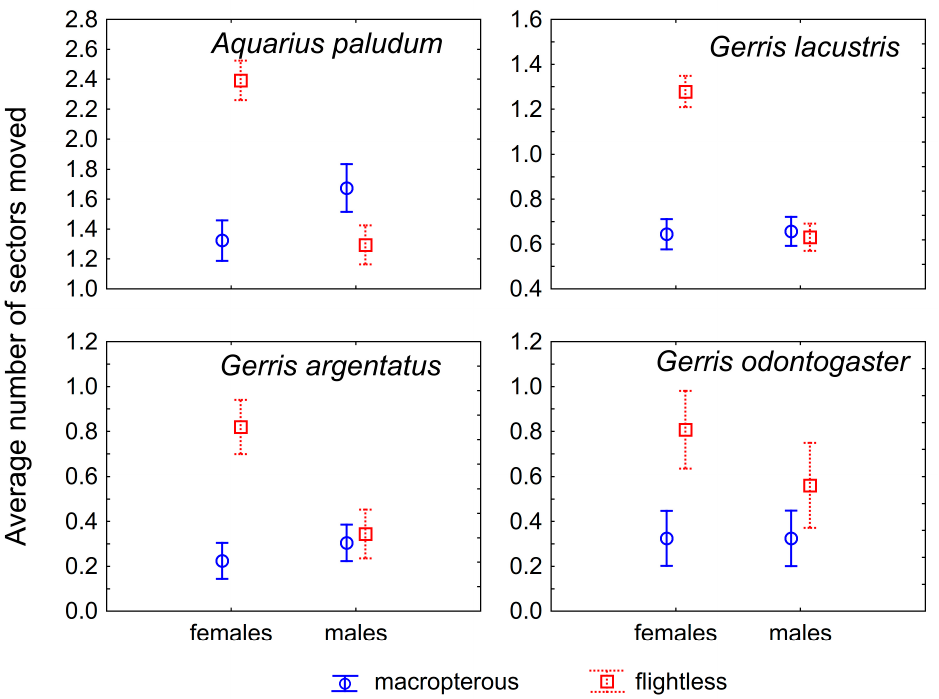
Figure 2. The mean of within-site movement in four wing dimorphic species; both sexes are displayed. Flightless females move significantly more than males and macropterous females. Vertical bars denote 0.95 confidence intervals. Table 2. Statistical significance of the effect of sex, wing morph and their interaction on intra-pond movement score. Data pooled from all seasons and both fishponds. NS = non-significant; * = p < 0.05; ** = p < 0.01; *** = p < 0.001. Species Sex Wing Morph Sex × Wing Morph